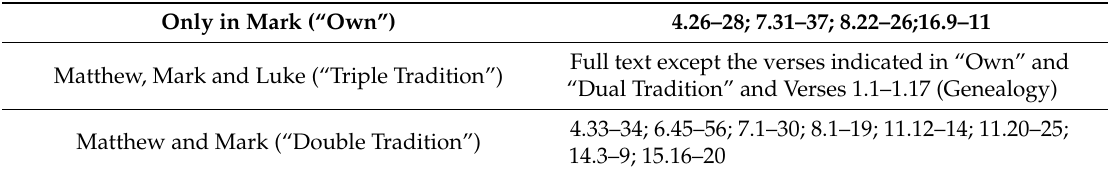
Table 2. List of the verses considered in Mark, in the indicated texts.